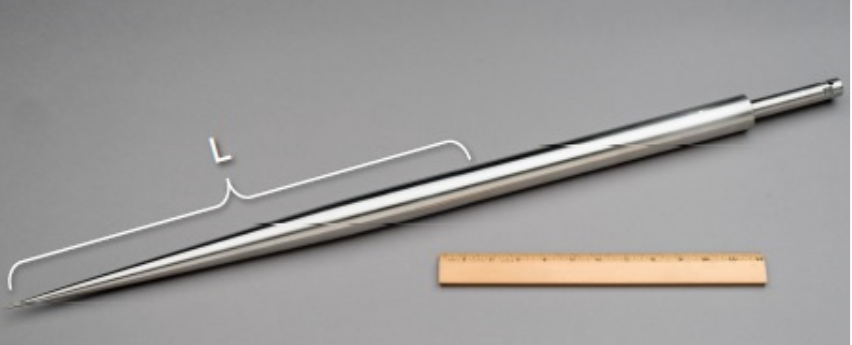
Figure 8. An axially symmetric body.